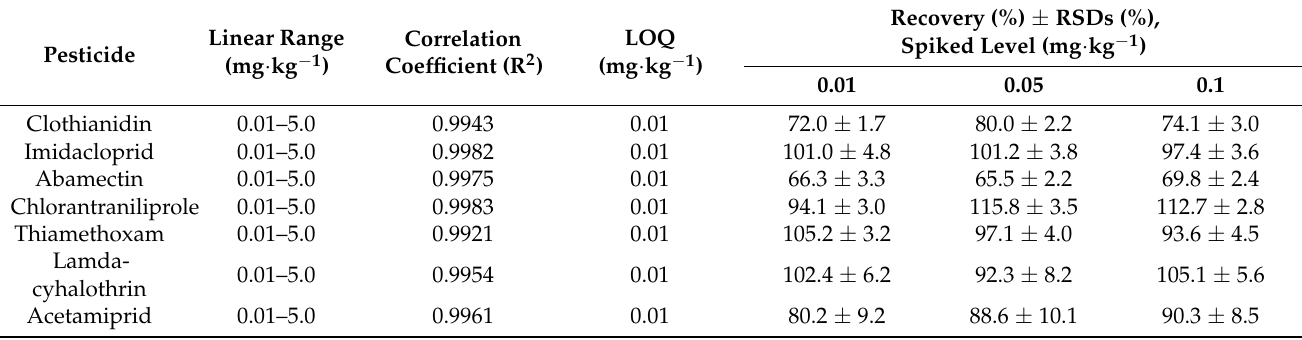
Table 2. Method validation of pesticides in a celery